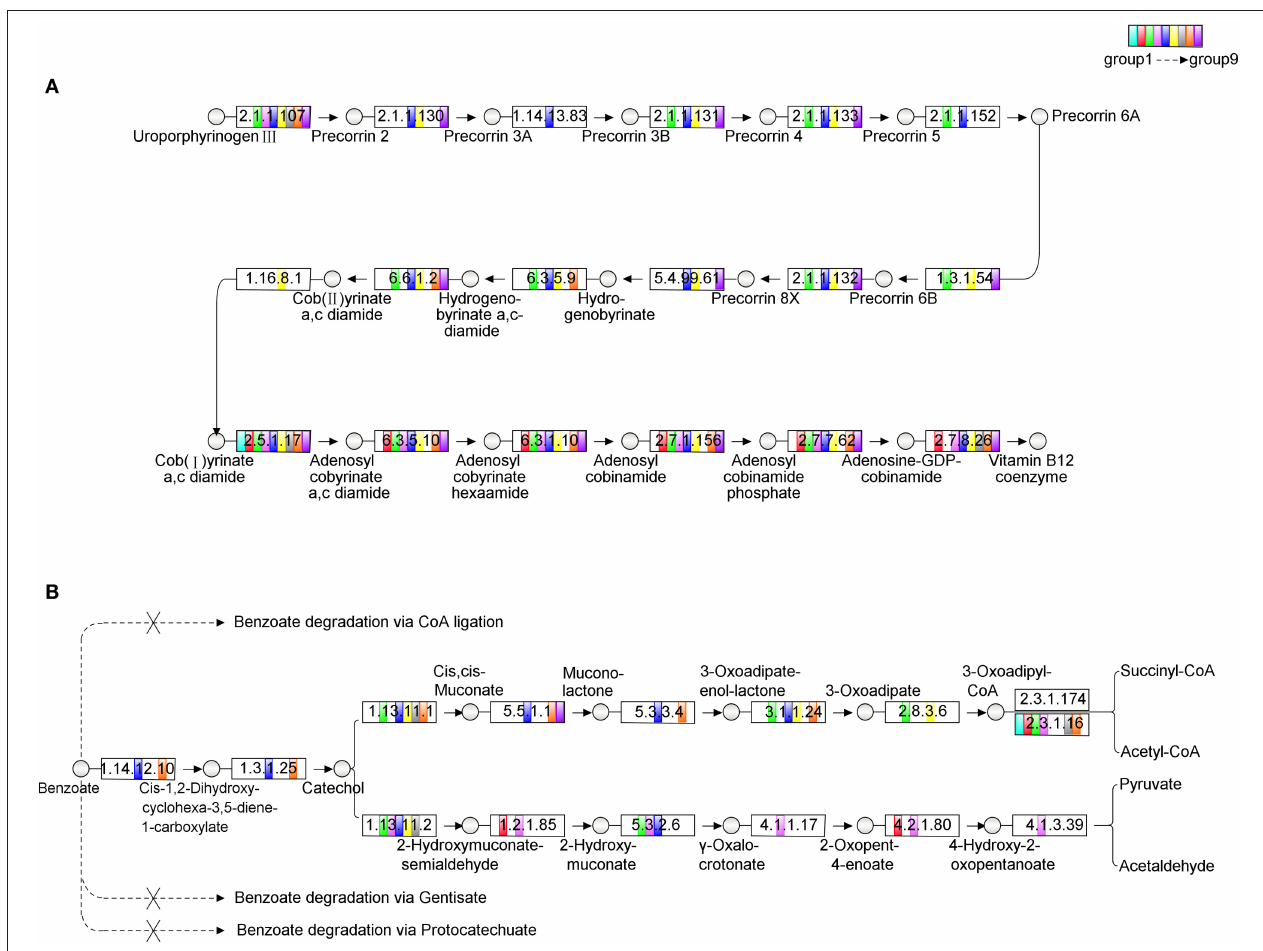
FIGURE 4 | The analysis of metabolic pathways among the microbial community. The circles in the figure represent the intermediates, the rectangles represent the enzymes. Different filled colors of rectangles represent the groups from the community, among which the white color indicates the absence of the corresponding enzyme in this group. (A) The aerobic biosynthesis pathway of Vitamin B12. The enzymes tagged by red rectangles are absent in Group 5, while the enzymes tagged by blue rectangles are absent in Group 6, but the pathway is completed with the combination of Group 5 and 6. (B) The metabolic pathway of benzoate degradation. In the metabolic diagram, only Group 5 and 8 participate consistently in the process of converting benzoate to 3-oxoadipate, while Group 3 and 6 then catalyze it to 3-oxoadipul-CoA with EC 2.8.3.6, which is absent in both Group 5 and 8 in our analysis. Through this kind of cooperation, the whole community can adapt for the complex